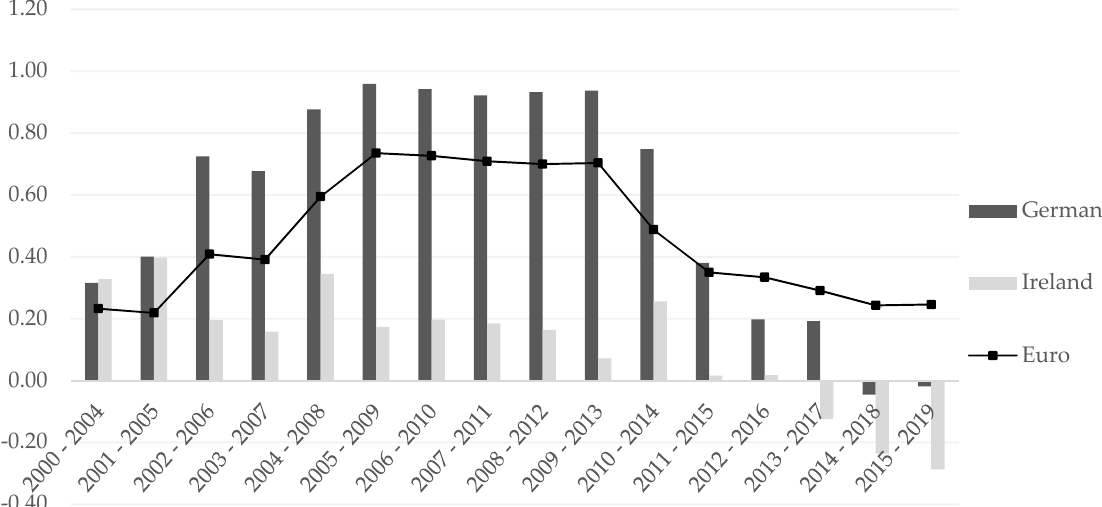
Figure 1. Correlation coefficients for real GDP growth rates. Source: Own calculations, based on Macrobond.